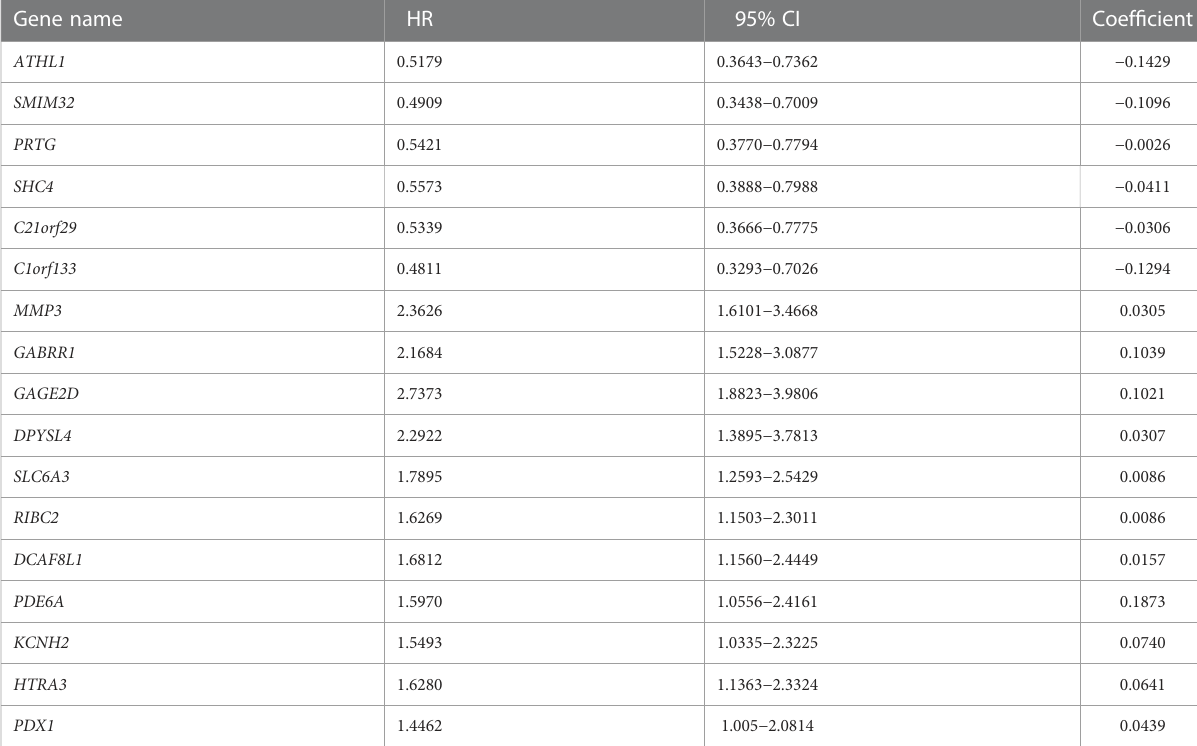
TABLE 2 A total of 17 genes included in overweight-associated genes signature. Gene